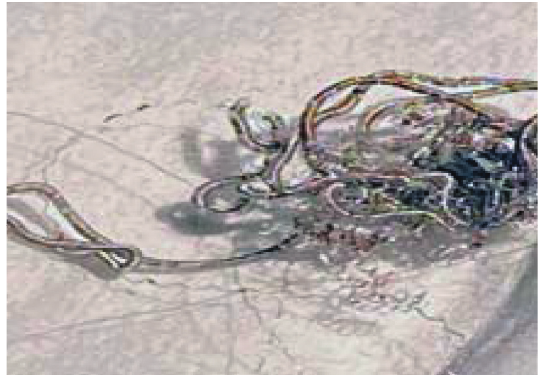
Figure 1: Dislocated removed coil material by the patient from his left nose.